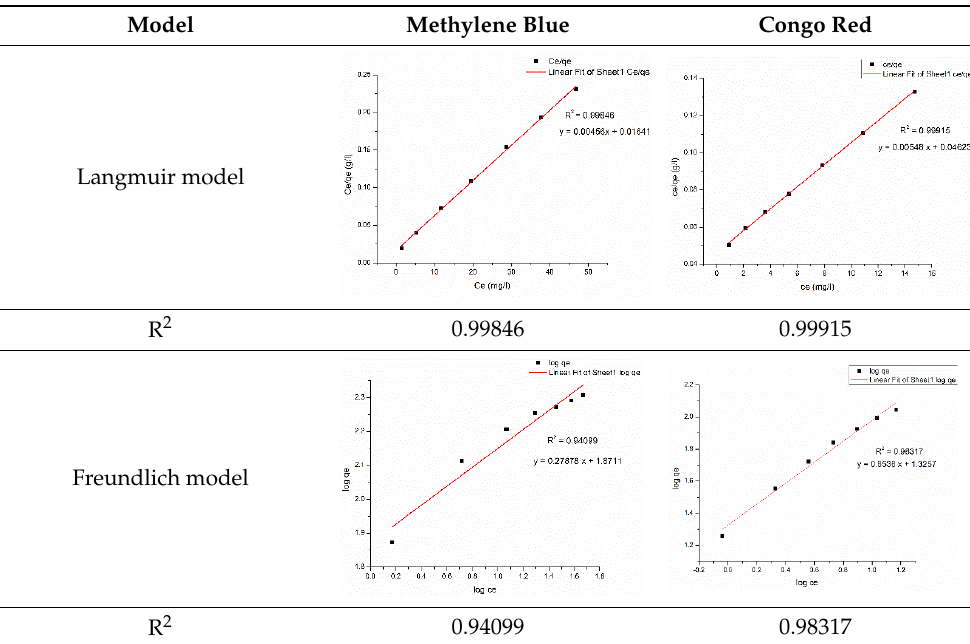
Table 2. Outcomes of Langmuir isotherm and Freundlich isotherm models.